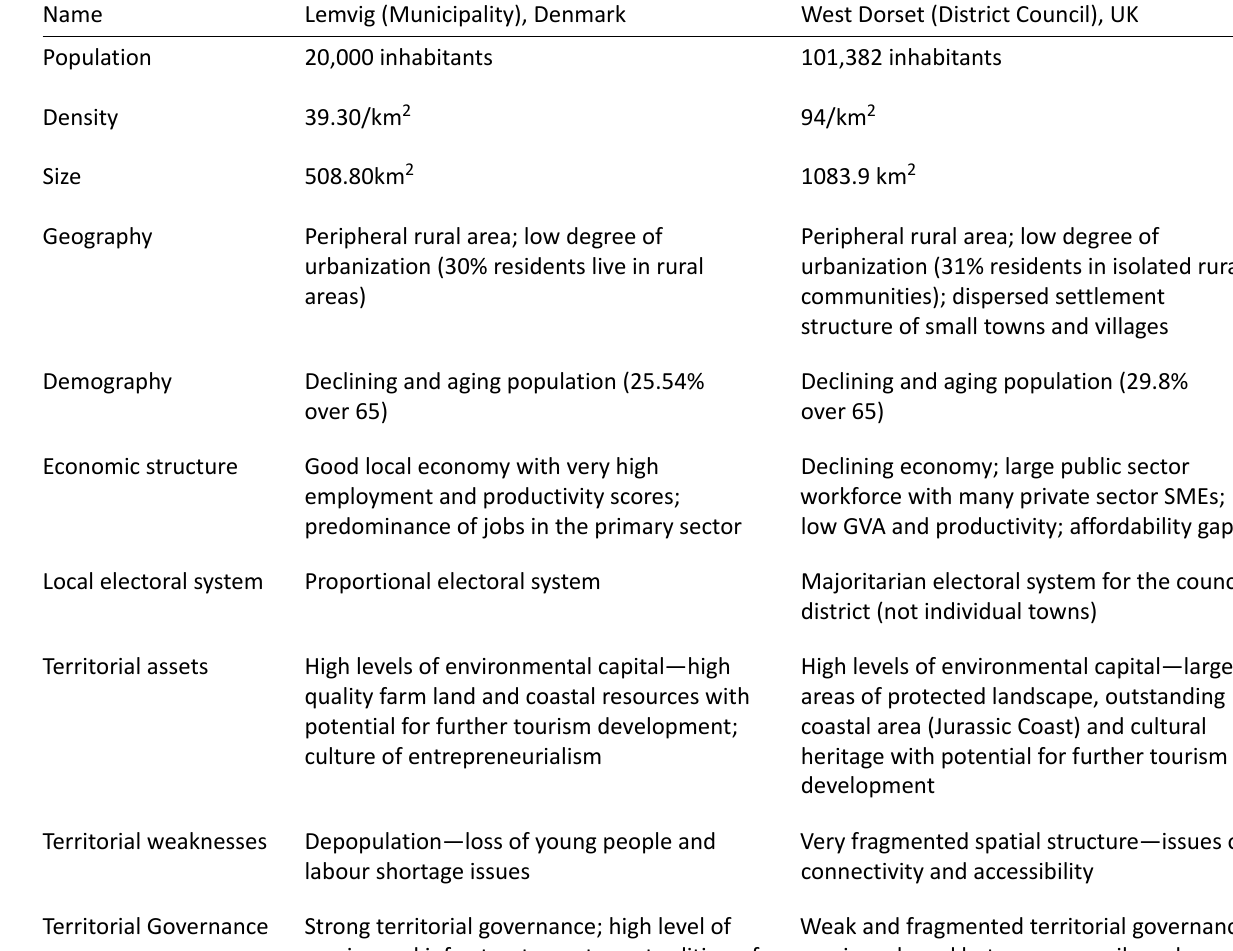
Table 1. Key characteristics of Lemvig and West